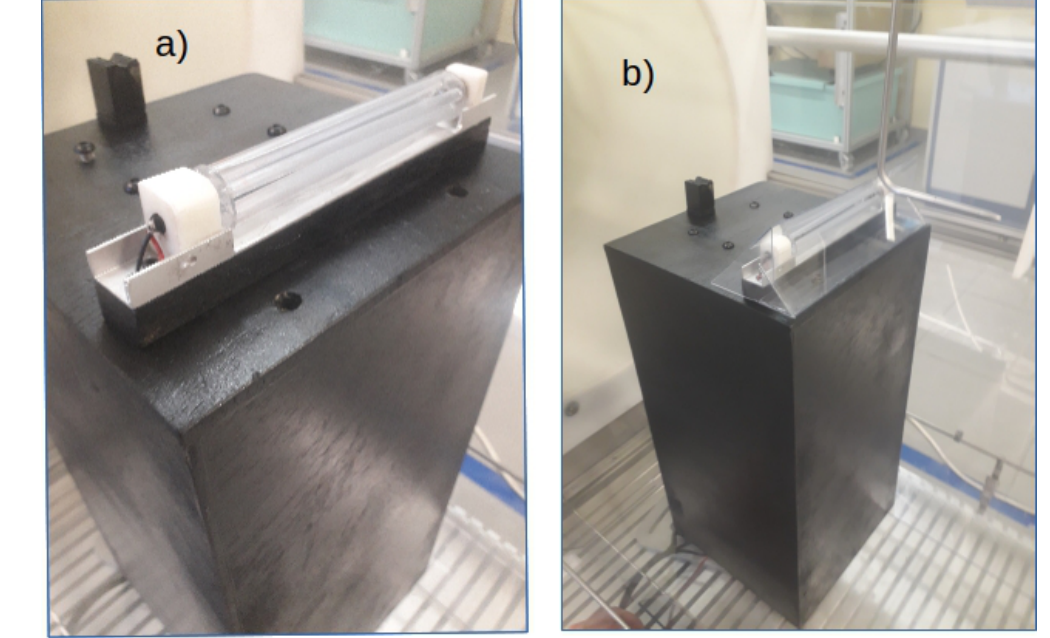
Figure 7. The small building model ( a ) without the vanes; and ( b ) with the